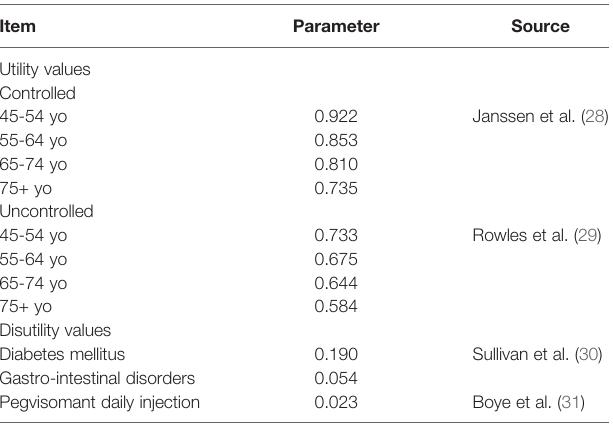
TABLE 4 | Utility and disutility inputs.